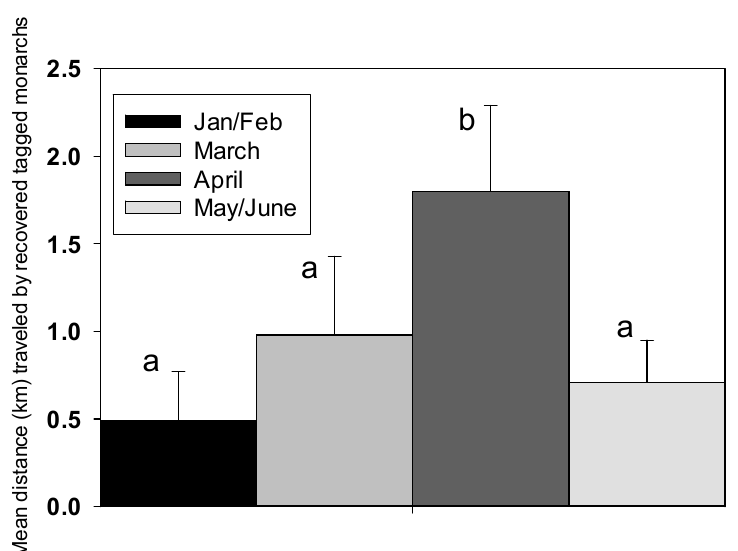
Figure 8. Mean ( ± SE) distances (km) flown by recovered tagged monarch butterflies in Santa Clara County, CA during January–June 2021. Column denoted by a different letter is significantly different ( p < 0.05).